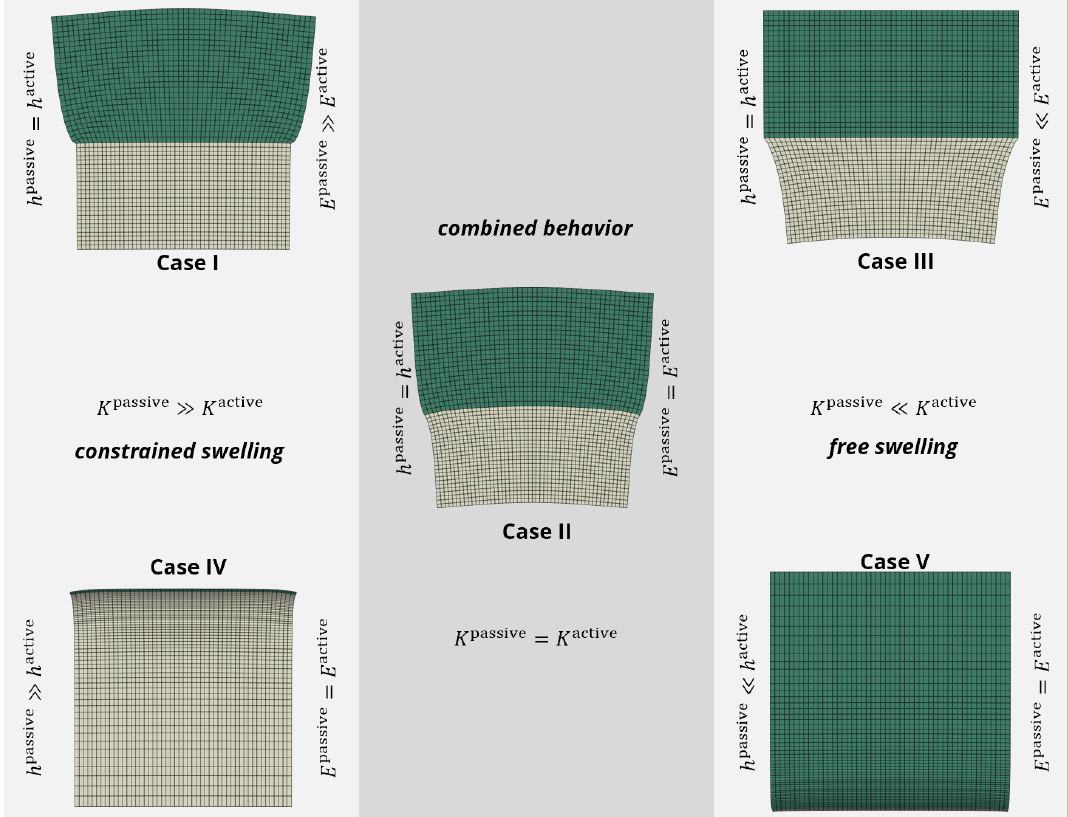
Figure 3. Comparison of different stiffness combinations between the active layer (upper, green) and the passive layer (lower, gray). The fixing is realized according to Figure